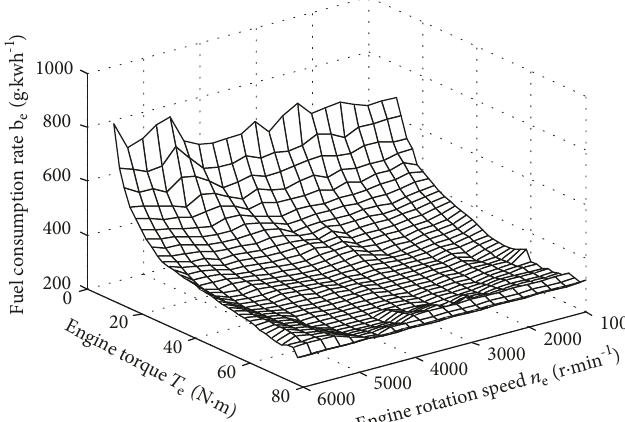
Figure 4: Engine fuel consumption rate